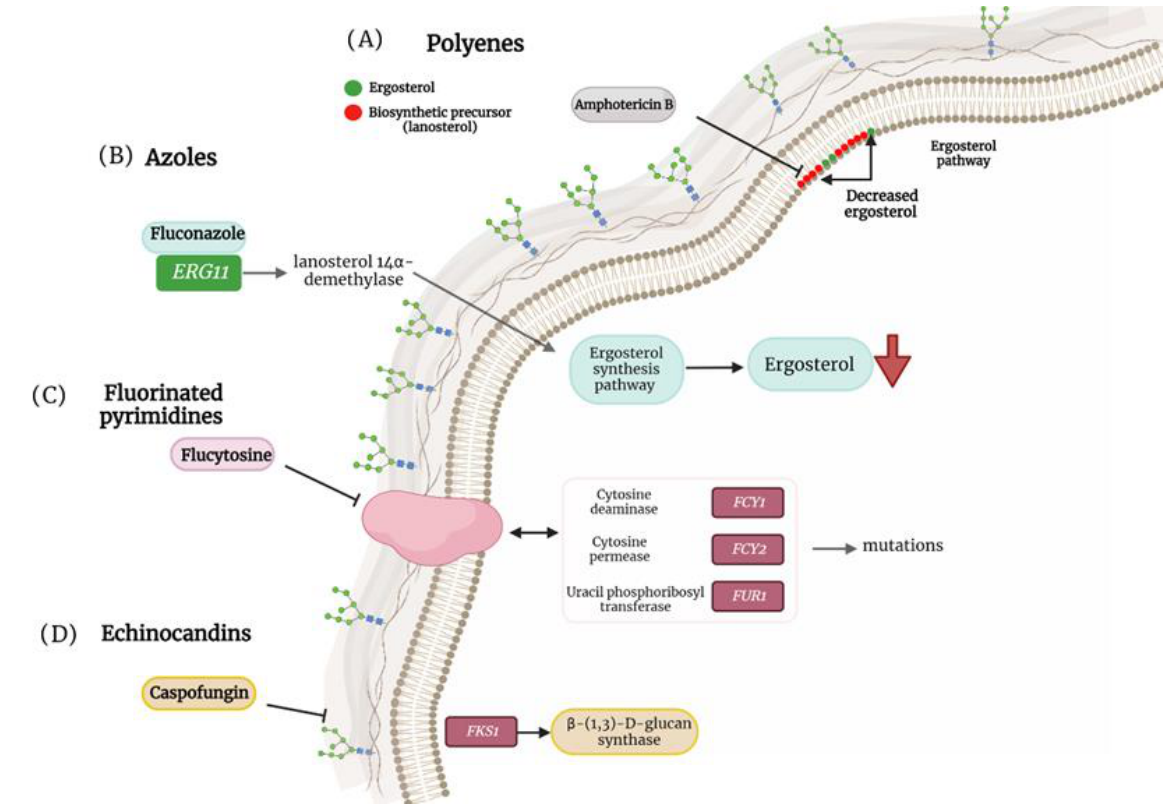
Figure 1. Antifungal resistance mechanisms in non- albicans Candida species. ( A ) Mutation in ergosterol biosynthesis that causes a decrease in the ergosterol content in the cell membrane and induces the replacement of biosynthetic precursors such as liquesterol and lanosterol. ( B ) Mutation in ERG11 that encodes the enzyme lanosterol 14α-demethylase, causing defects in ergosterol synthesis. ( C ) Mutation in cytosine deaminase ( FCY1 ), cytosine permease ( FCY2 ) and uracil phosphoribosyltransferase ( FUR1 ) facilitating resistance to flucytosine. ( D ) Mutation in FKS1 that generates resistance to caspofungins.